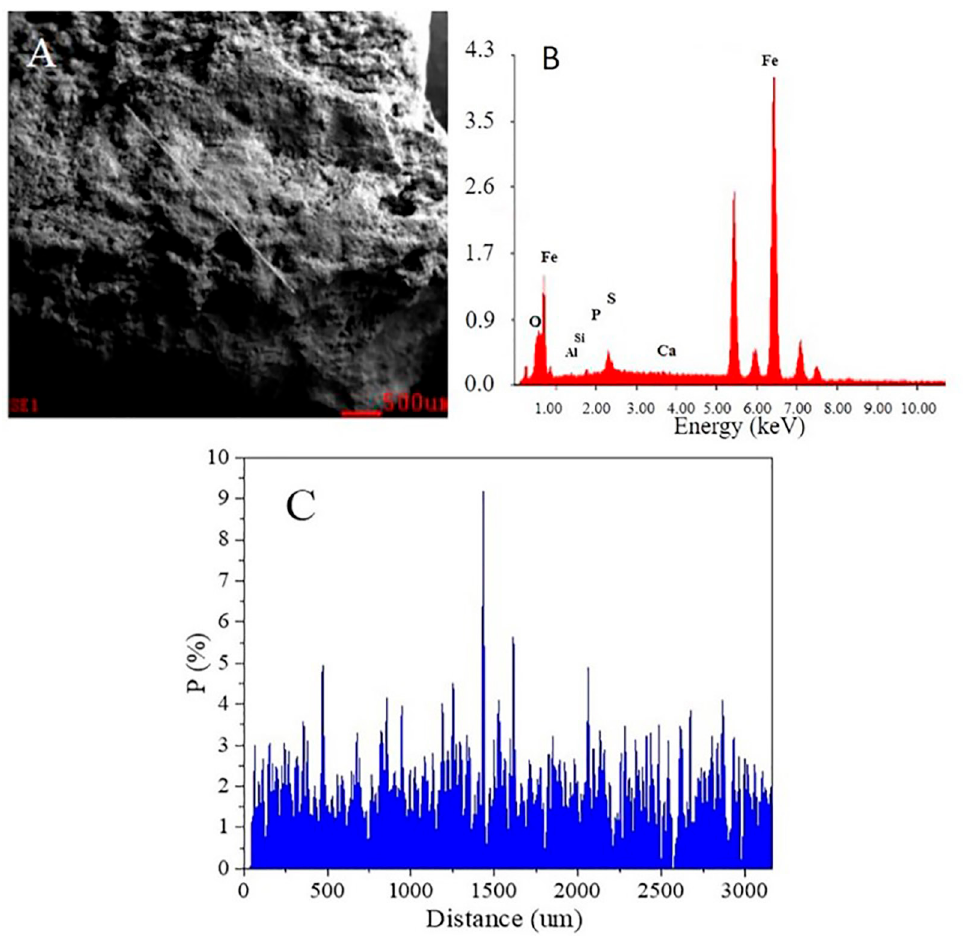
Figure 8. Micrographs of the ore fines with mean particle size of 4 mm treated by microwave energy (A) graphs of particle surface composition (B) and distribution of phosphorus along the particle